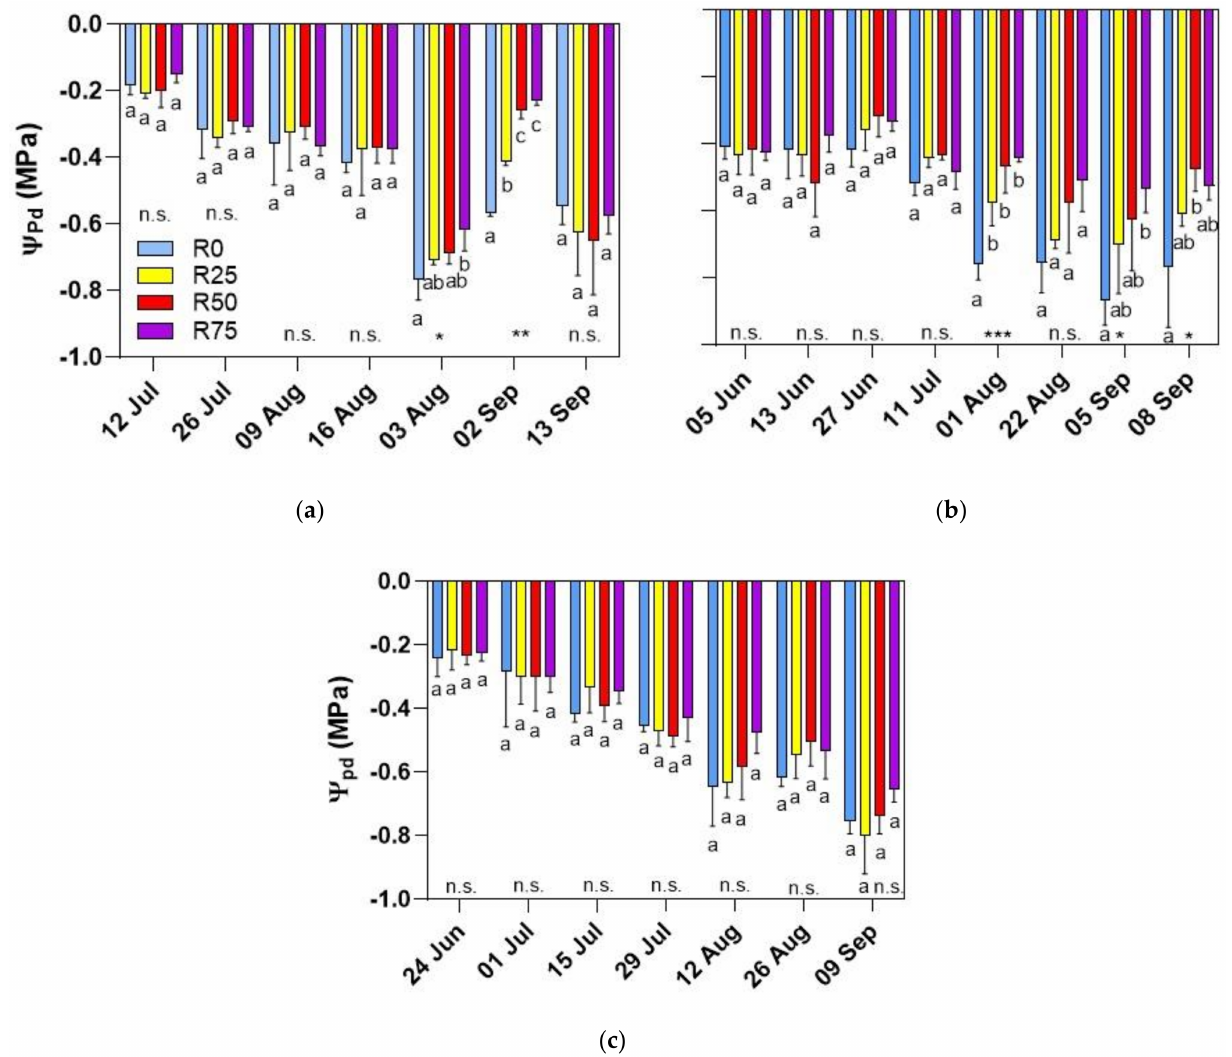
Figure 1. Seasonal variation of predawn leaf water potentials for Touriga Francesa cultivar under rainfed and irrigation conditions in ( a ) 2018, ( b ) 2019, and ( c ) 2020. Values are represented as mean ± standard deviation. Asterisks indicate significant differences between treatments at p < 0.05; n.s.—non significative. Days represented by different letters indicate significant differences between